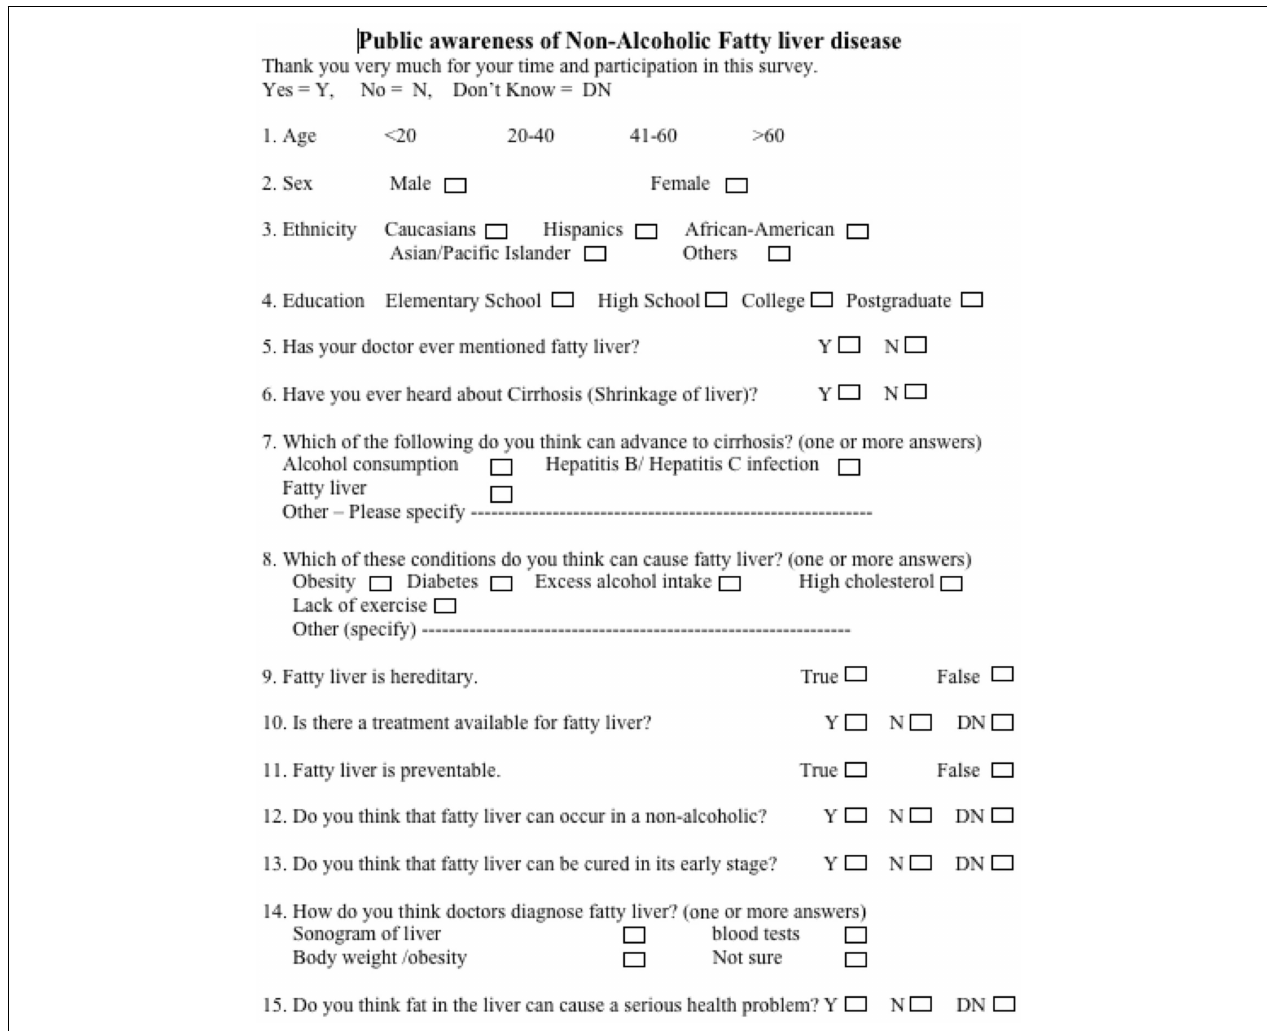
FIGURE 1 | Survey questionnaire . NAFLD, non-alcoholic fatty liver